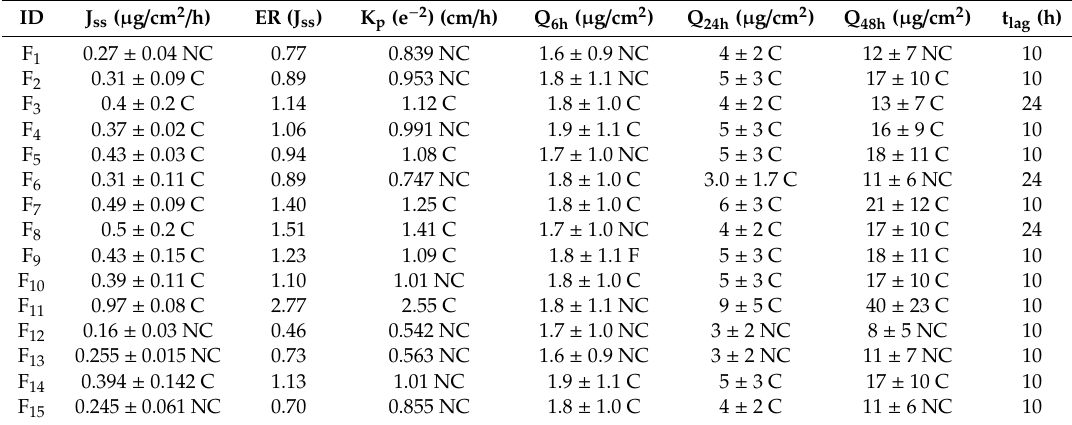
Table 9. E ff ect of independent variables on cream permeation profile. Permeation parameters according to experimental permeation data. Data are expressed as mean ± SD (n =